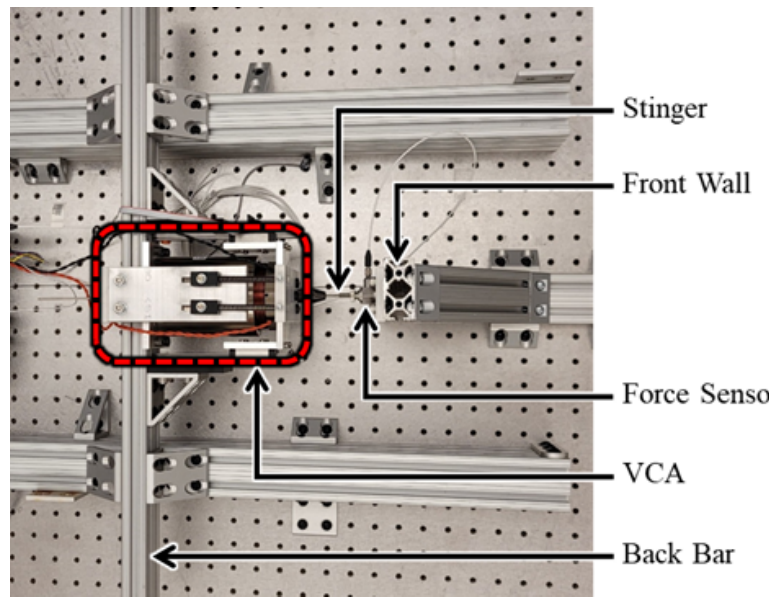
Figure 8. Testbed for the output force bandwidth